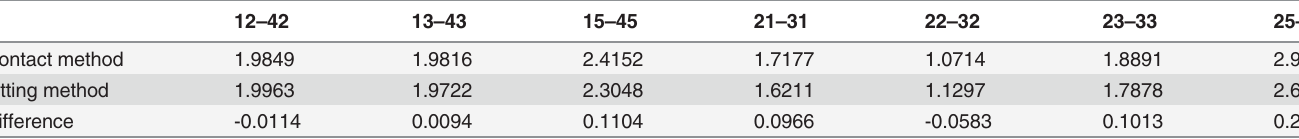
Table 2. Measurement results of the straight-line distance at the X-axis (unit: mm).